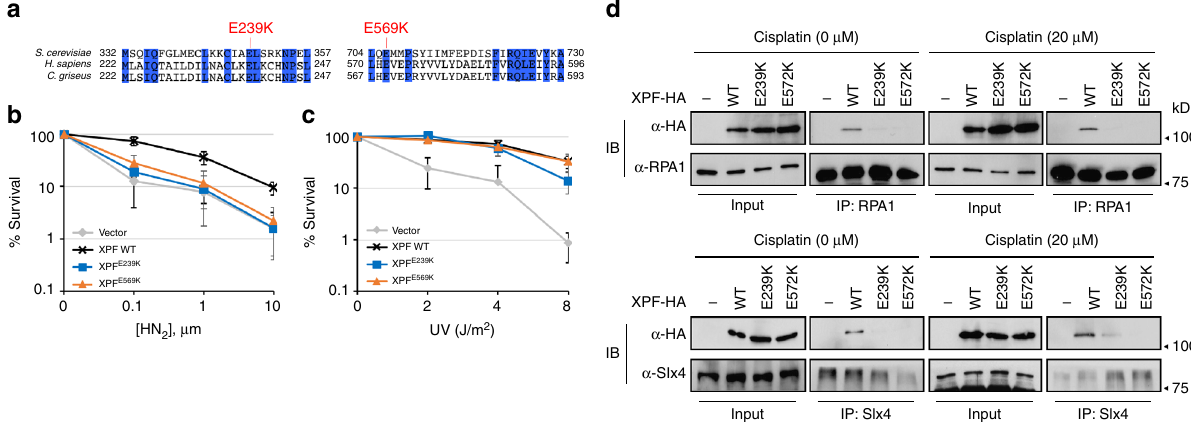
Fig. 6 Effect of XPF mutations on ICLR. a Homology between XPF sequences in S. cerevisiae , H. sapiens , and C. griseus at the regions fl anking rad1 mutations. The amino acids identical to all three species are shown in blue. b , c Percentage of survival of XPF E239K and XPF E569K was calculated by dividing the number of exposed cells with the number of non-exposed cells upon treatment of different doses of HN 2 ( b ) and UV ( c ). d Co-immunoprecipitation of C- terminal HA tagged XPF, XPF E239K , or XPF E572K with Rpa1 or SLX4. 293T cells were transfected with pcDNA3.1-XPF-HA or the mutant variants and subjected to 20 μ m cisplatin treatment for 2 h. Cell lysates were prepared and analyzed by immunoprecipitation and immunoblot assays with antibodies as described in Methods. Input (2%) is